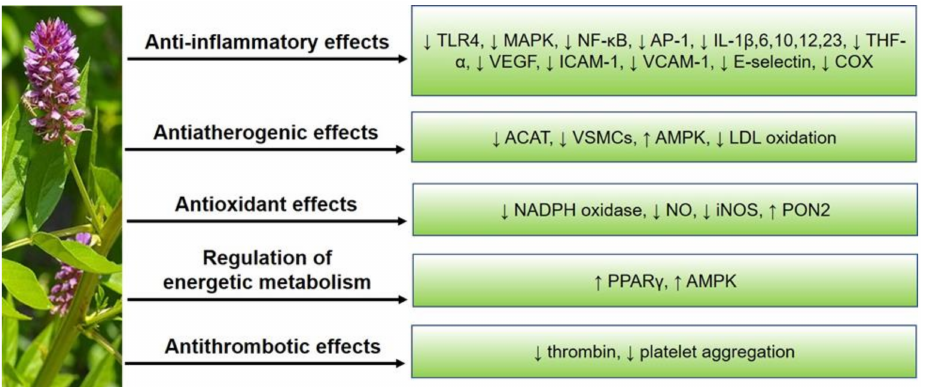
Figure 1. Anti-atherosclerotic effects of G. glabra . TLR4, toll-like receptor 4; MAPK, mitogen-activated protein kinase; NF- κ B, nuclear factor- κ B; AP-1, activator protein-1; IL, interleukins; TNF, tumor necrosis factor; VEGF, vascular endothelial growth factor; ICAM-1, intercellular adhesion molecule-1; VCAM-1, vascular cell adhesion molecule-1; COX, cyclooxygenase; ACAT, acyl-CoA cholesterol acyltransferase; VSMCs, vascular smooth muscle cells; AMPK, adenosine monophosphate-activated protein kinase; LDL, low-density lipoproteins; NADPH oxidase, nicotinamide adenine dinucleotide phosphate oxidase; NO, nitric oxide; iNOS, inducible nitric oxide synthase; PON2, paraoxonase 2; PPAR γ , peroxisome proliferator-activated receptor γ